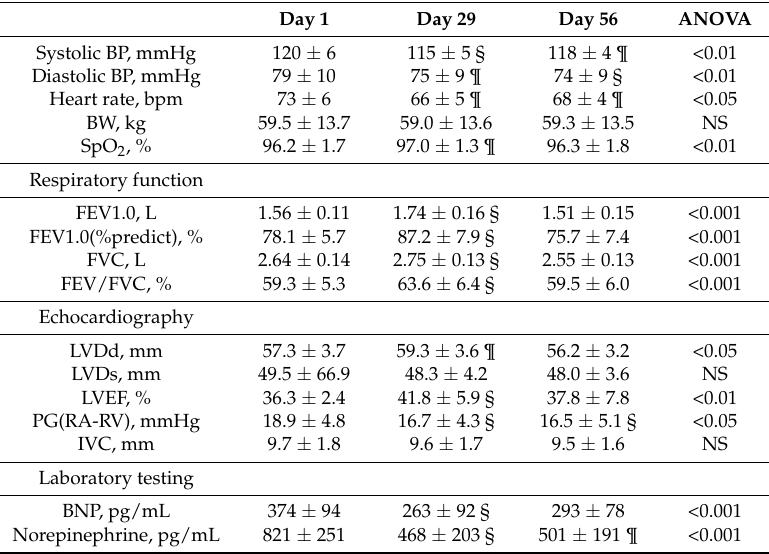
The shaded part of the table indicates the periods of inhalation of tiotropium. § = p < 0.01, ¶ = p < 0.05 vs. before inhalation, respectively; 6MWD = 6-min walk distance, BP = blood pressure, bpm = beats per minute, BW = body weight, SpO 2 = arterial oxygen saturation, FEV = forced expiratory volume, FVC = forced vital capacity, LVDd = diastolic left ventricular diameter, LVDs = systolic left ventricular diameter, LVEF = left ventricular ejection fraction, PG(RA-RV) = pressure gradient between the right atrial and right ventricular chamber, IVC = diameter of the inferior vena cava, BNP = brain natriuretic peptide, ANOVA = repeated-measures analysis of variance, NS = no significant